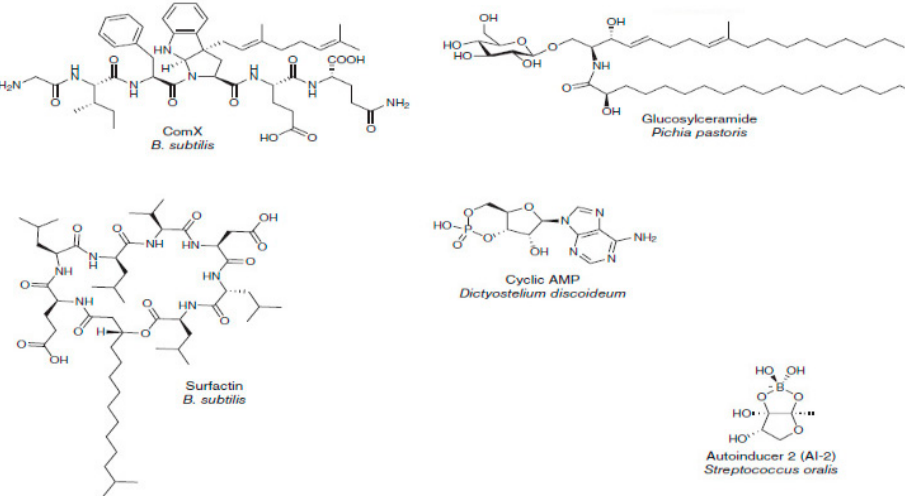
Figure 12. Examples of low-diversity molecules in the MDDR dataset.